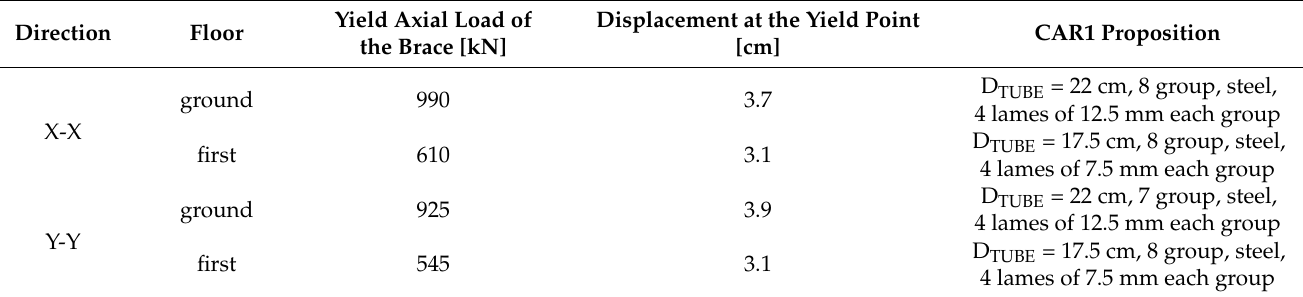
Figure 6. Model configuration of CAR1 damper. Table 2. Description of the selected characteristics of the CAR1 dampers for RD1.